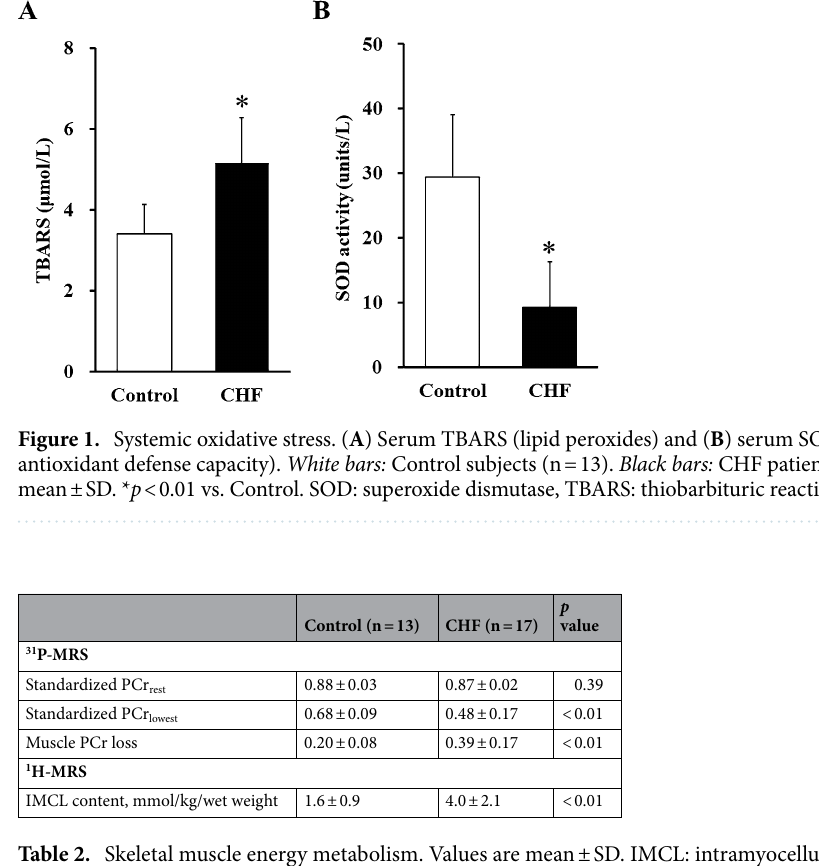
Table 2. Skeletal muscle energy metabolism. Values are mean ± SD. IMCL: intramyocellular lipid, PCr: phosphocreatine, PCr rest : PCr level at rest, PCr lowest : the lowest PCr level during plantar-flexion exercise with constant load of 20% one repetition maximum.